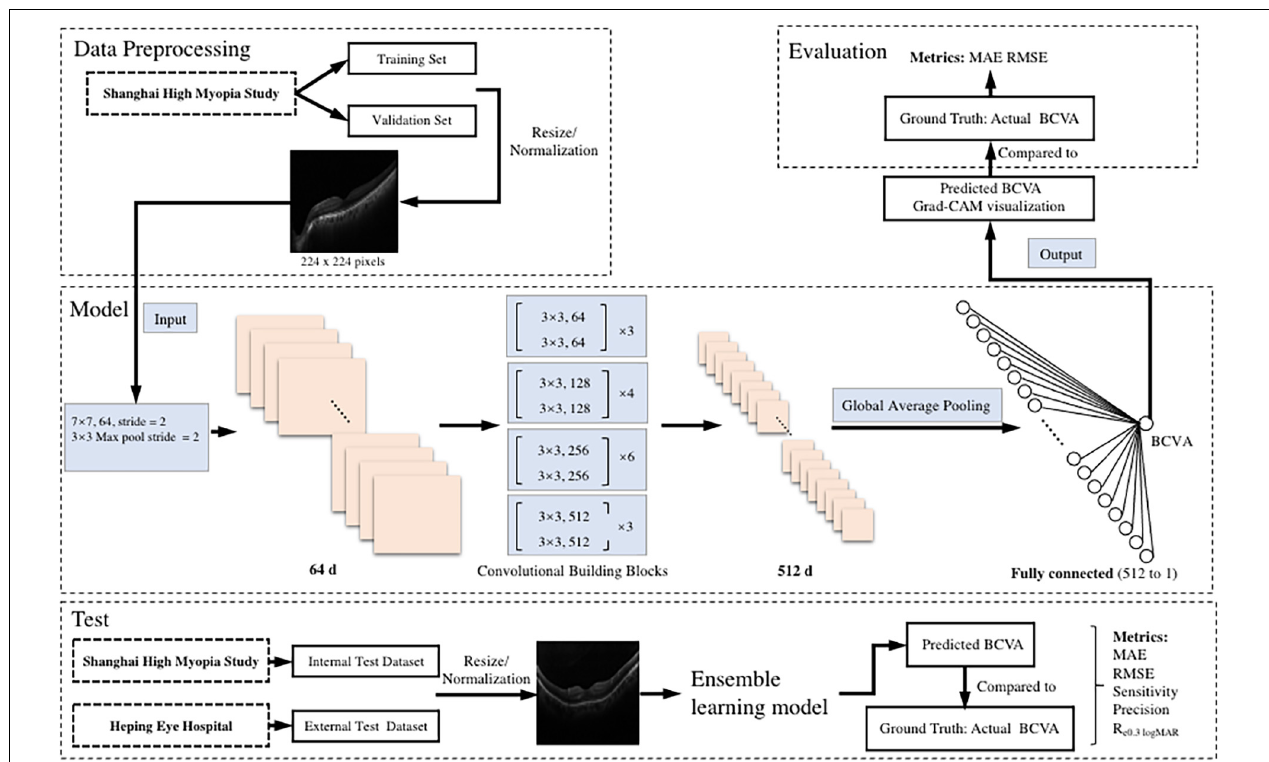
FIGURE 1 | An illustration of the pipeline of the tasks. The preoperative b-scan OCT image is fed into the model. It eventually outputs the prediction of postoperative BCVA. BCVA, best corrected visual acuity; logMAR, logarithm of the minimum angle of resolution; MAE, mean absolute error; RMSE, root mean square error; R e0 . 30logMAR , the percentage of BCVA prediction errors within ± 0.30